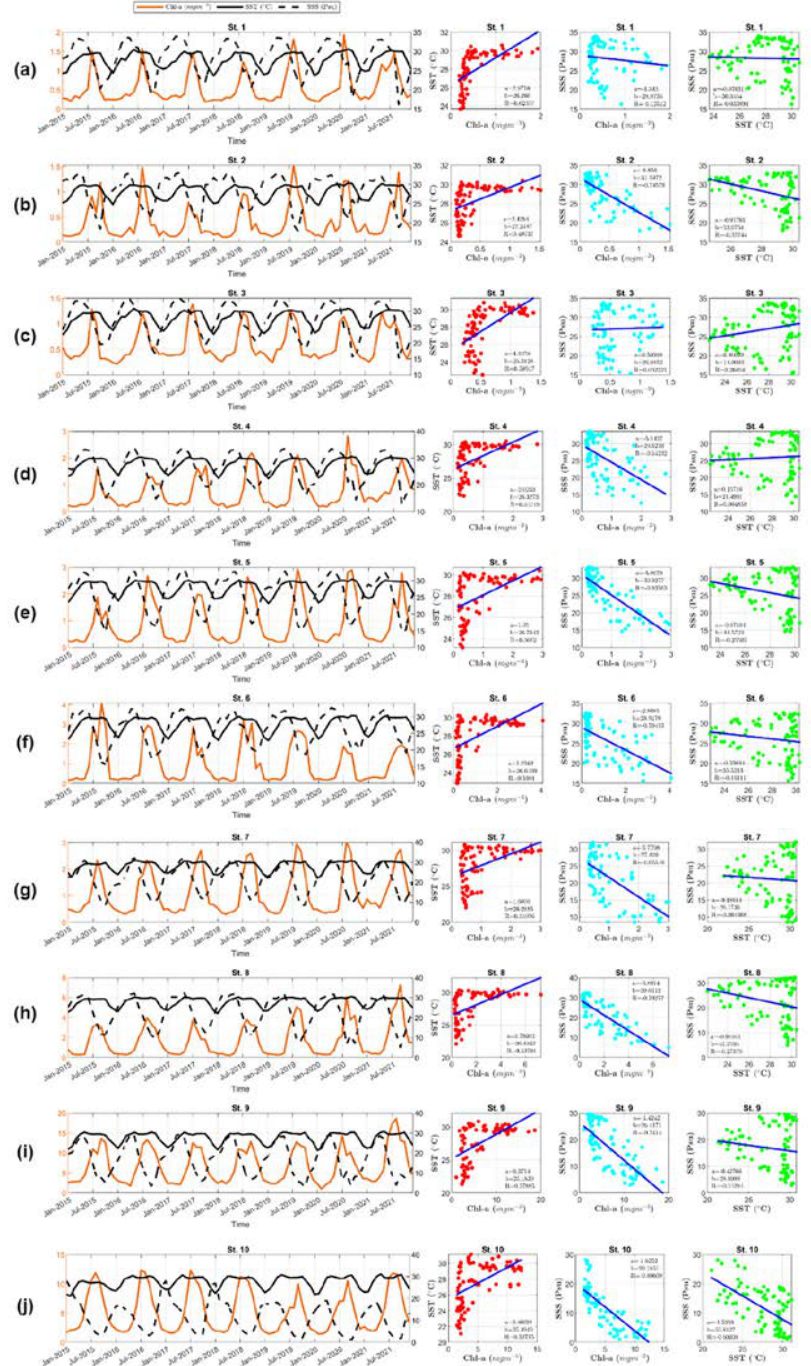
Fig. 5: (First column) Time series of Chl-a concentration (in solid brown line color), SST (in solid black line color), and SSS (in dashed black line) in the 10 stations (St. 1-10), which is marked by (a-j). Correlation analysis for Chl-a and SST (Second column), Chl-a and SSS (Third column), and SST and SSS (Fourth column) in the 10 stations (St. 1‐ 10).